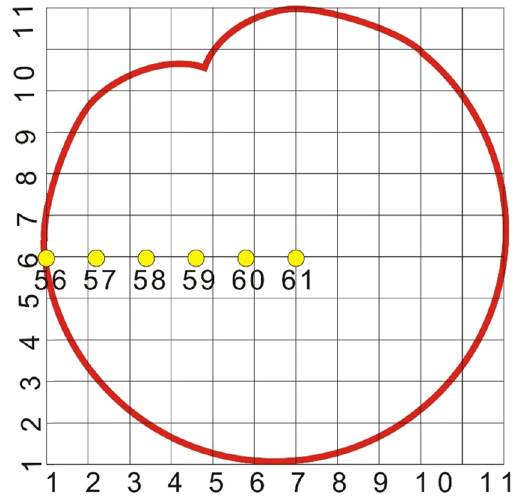
Figure 2: Cross - section diagram of MTC the examined fi ber.